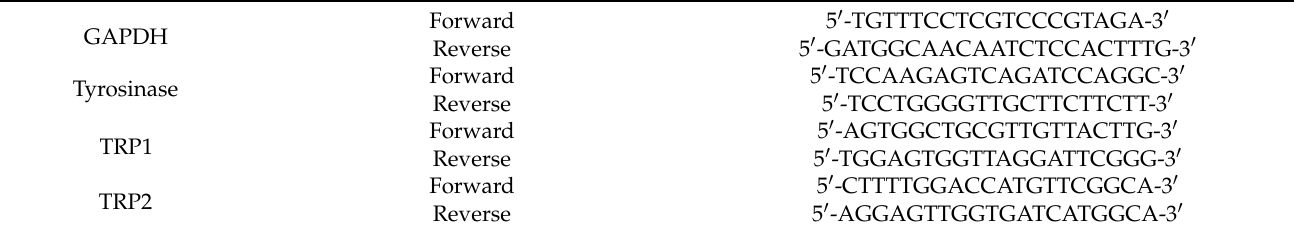
Table 1. The primer sequences used in the real-time polymerase chain reaction measurement for GAPDH (glyceraldehyde 3-phosphate dehydrogenase, internal standard), tyrosinase, tyrosinase related protein-1 (trp-1), and tyrosinase related proten-2